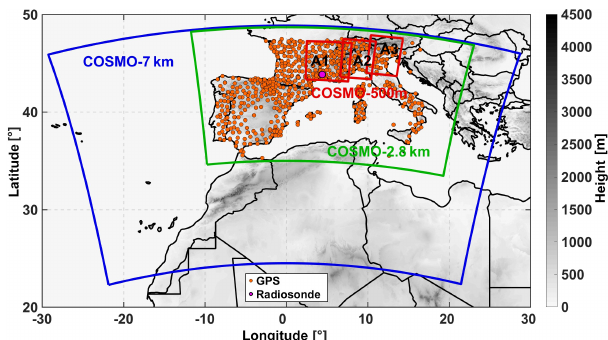
Figure 1. The 7km, 2.8km and 500m simulation regions are de- noted by the blue, green and red frames respectively. The GPS sta- tions location is denoted by the orange dots and the location of the shown radiosonde measurement (see Fig. 3b) is indicated by the purple